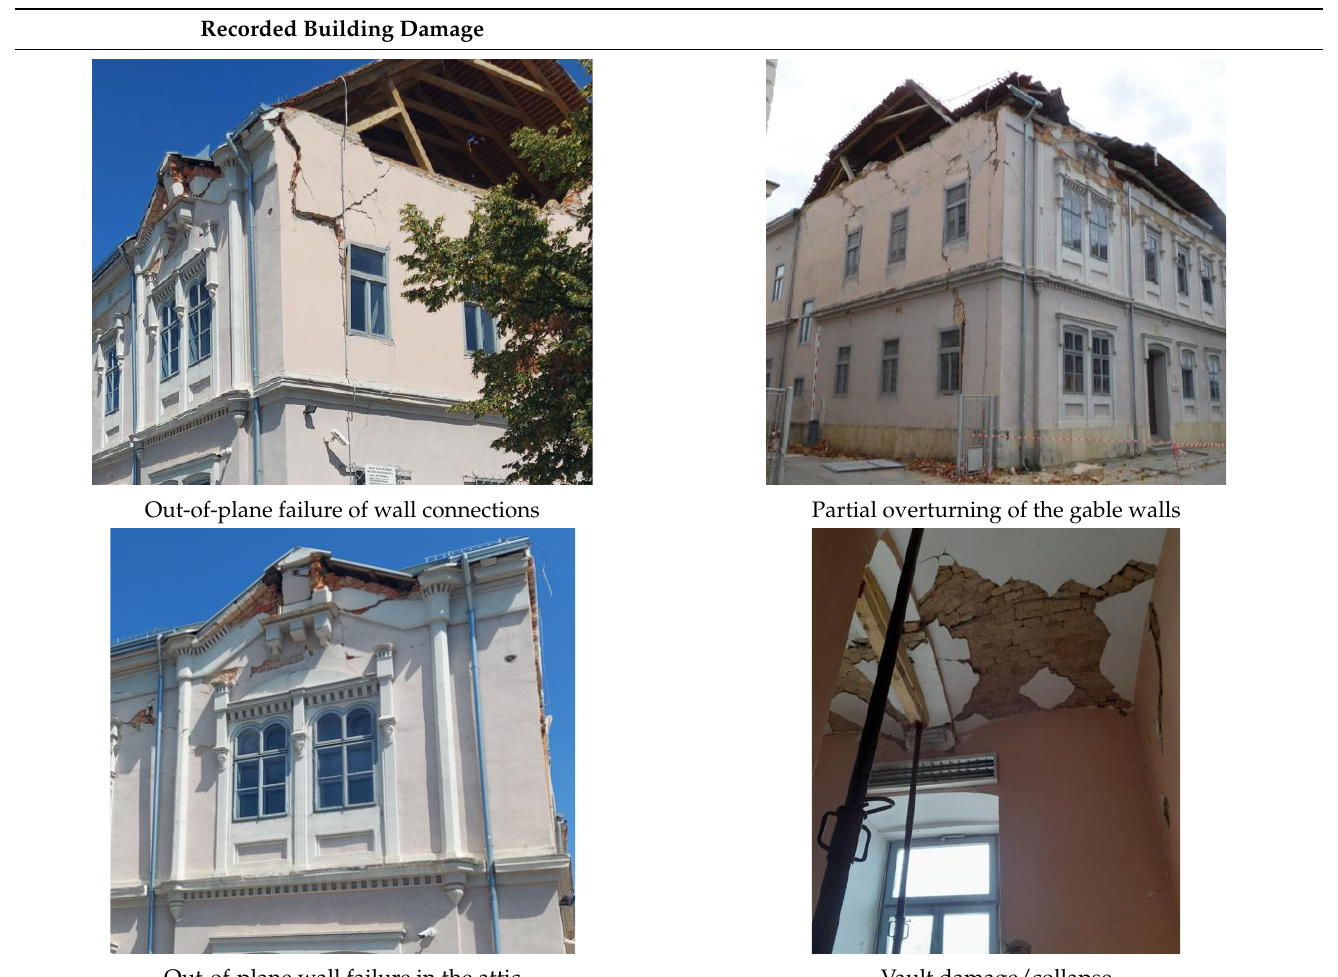
Figure 12. Northeastern façade plan with marked damage. Table 1. Typical damages of the case-study building.